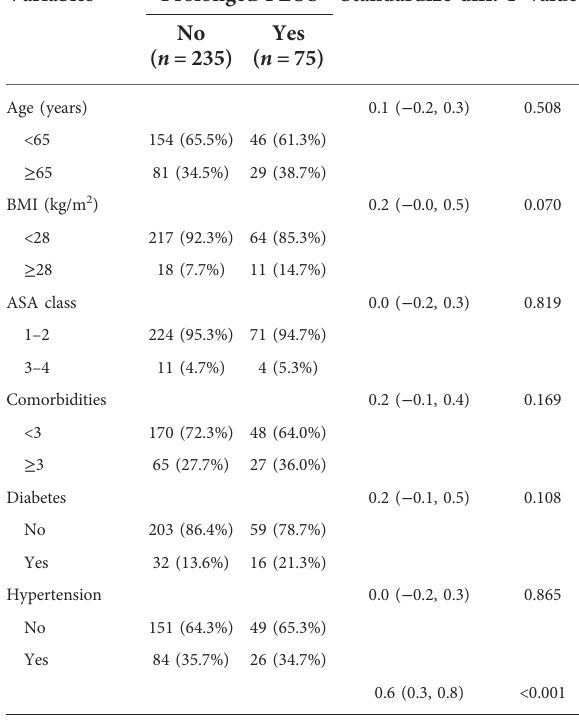
TABLE 1 Differences between demographic and clinical characteristics of prolonged PLOS and non-prolonged PLOS groups.